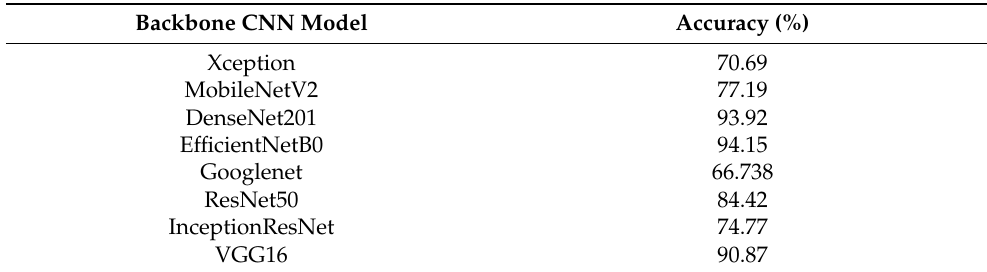
Table 4. A comparison of the performance of the features extracted by applying PCA and LDA on the last convolution layers of different CNN backbone models without finetuning. The results were obtained using SA-CRC on UFPR